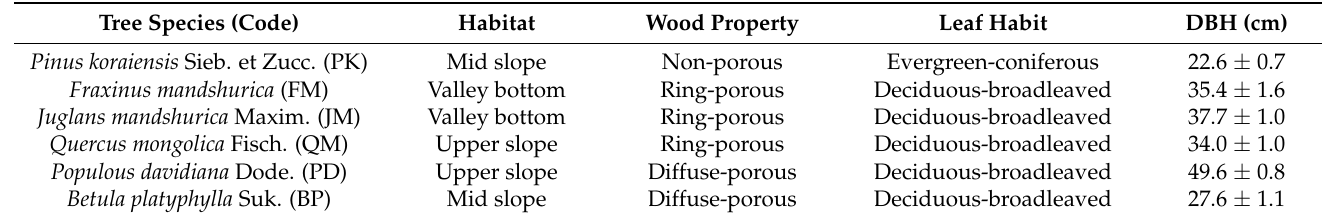
Table 1. Basic characteristics of the sampled trees for the six temperate tree species ( mean ± SE , n = 4 ). Tree Species (Code) Habitat Wood Property Leaf Habit DBH (cm) Pinus koraiensis Sieb. et Zucc. (PK) Mid slope Non-porous Evergreen-coniferous 22.6 ± 0.7 Fraxinus mandshurica (FM) Valley bottom Ring-porous Deciduous-broadleaved 35.4 ± 1.6 Juglans mandshurica Maxim. (JM) Valley bottom Ring-porous Deciduous-broadleaved 37.7 ± 1.0 Quercus mongolica Fisch. (QM) Upper slope Ring-porous Deciduous-broadleaved 34.0 ± 1.0 Populous davidiana Dode. (PD) Upper slope Diffuse-porous Deciduous-broadleaved 49.6 ± 0.8 Betula platyphylla Suk. (BP) Mid slope Diffuse-porous Deciduous-broadleaved 27.6 ±